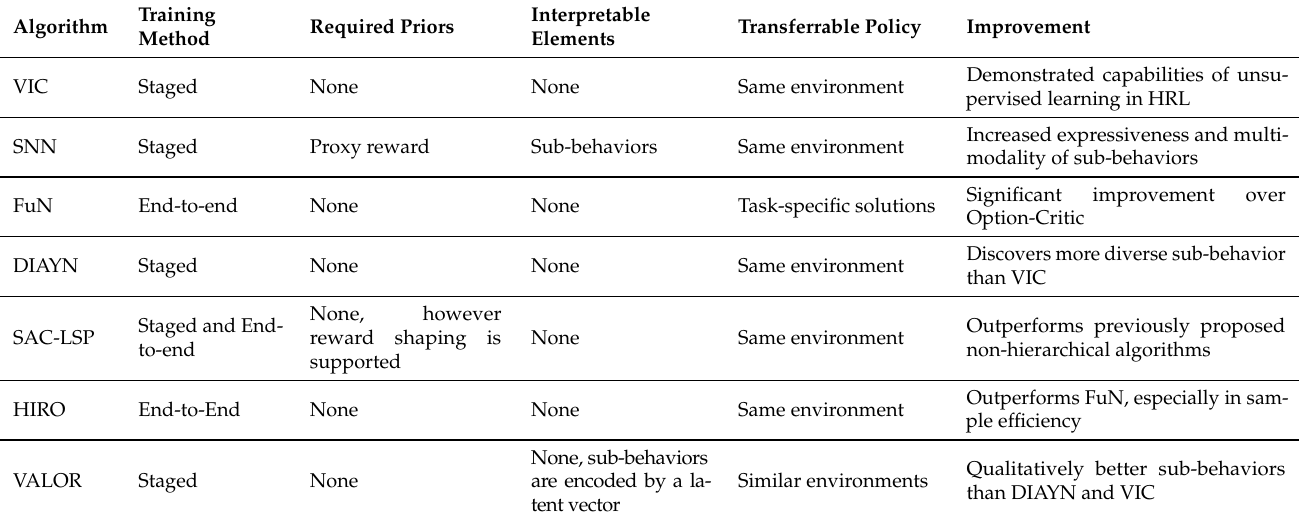
Table 4. Evaluation of goal-conditional